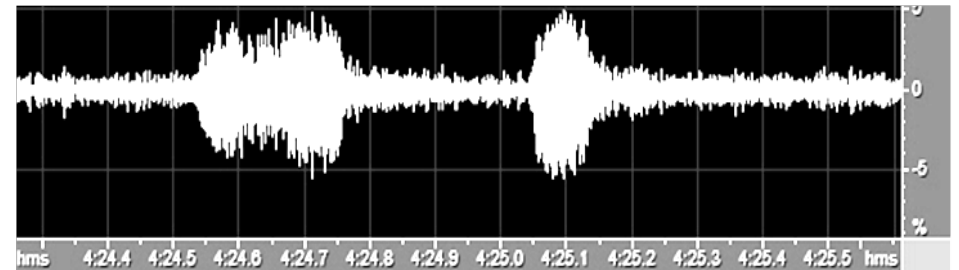
Figure 1. Screenshot of a cook pheasant vocalization oscillogram in Cool Edit Pro.